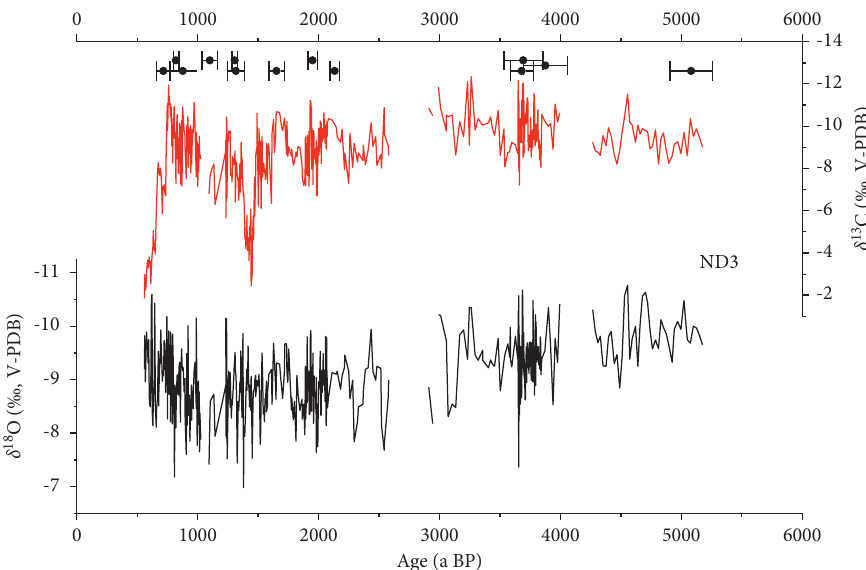
Figure 3: Stable isotope records of stalagmite ND3 from Naduo Cave.